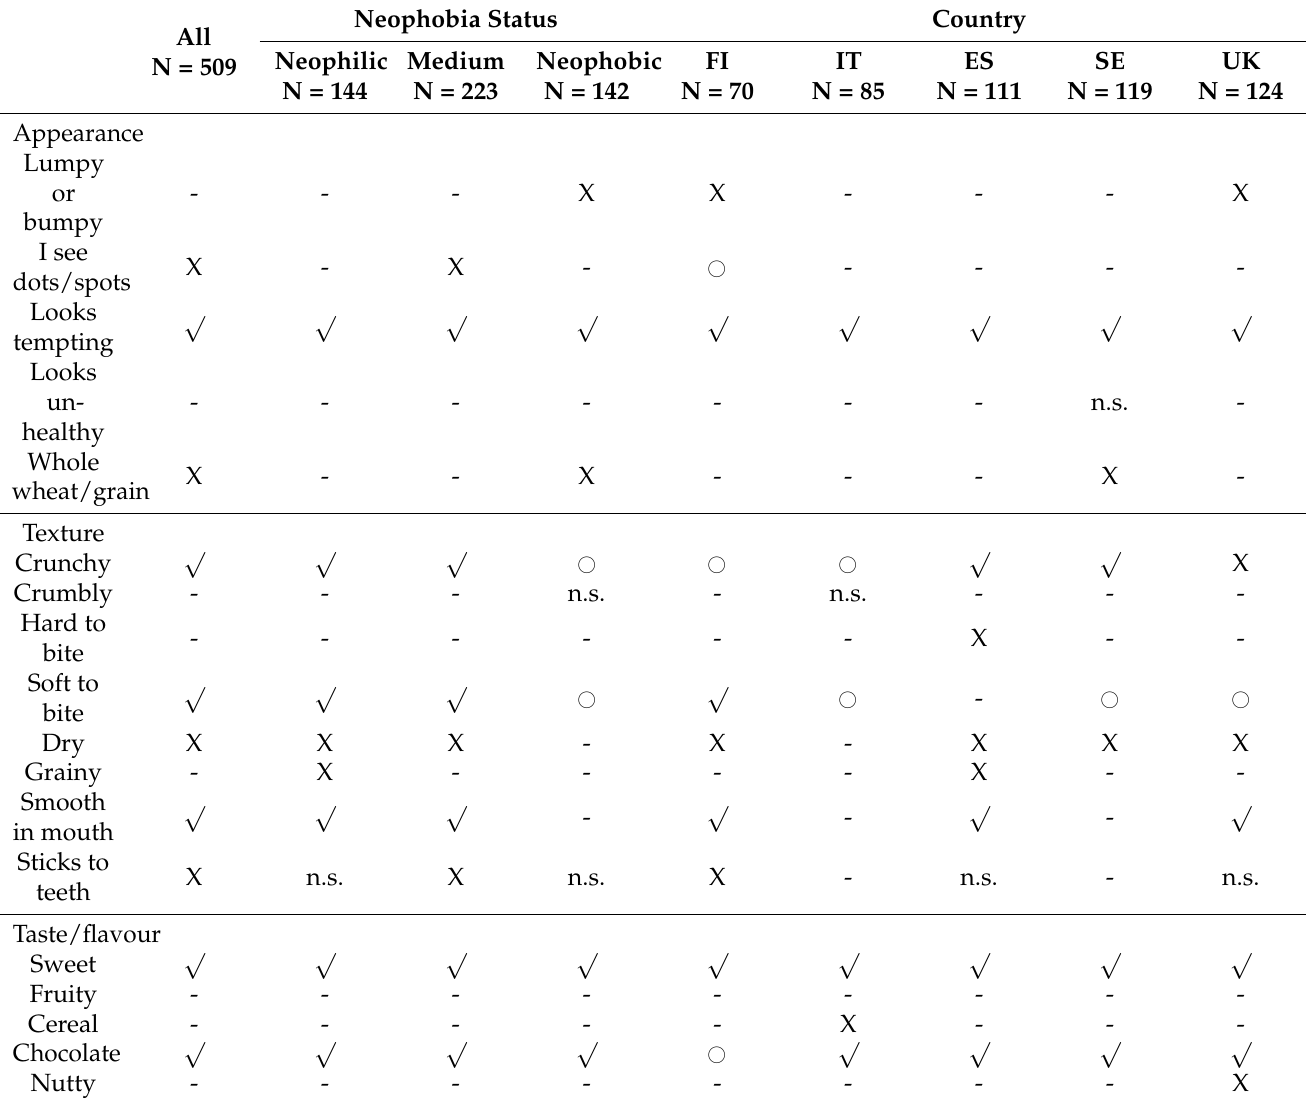
Table 5. Drivers of liking and disliking identified by penalty